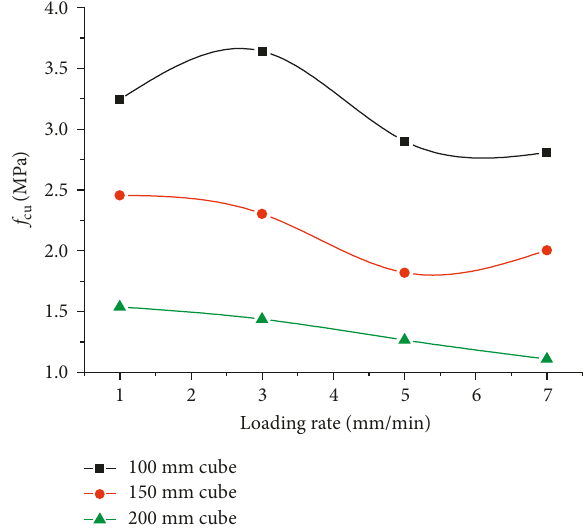
Figure 4: Compression strengths of cubes under different loading